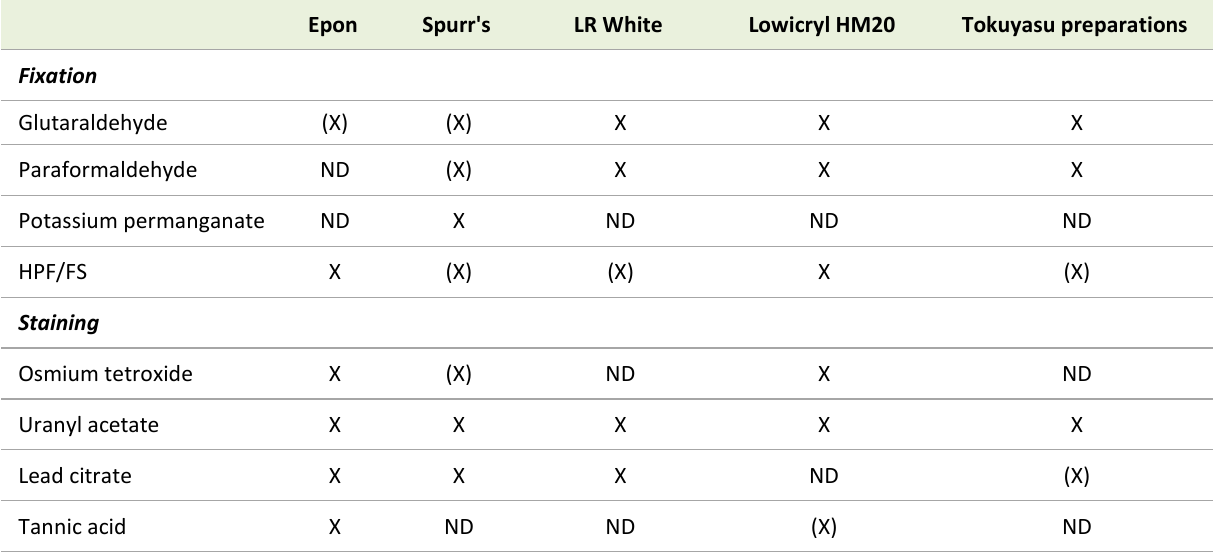
TABLE 2. Combinations of embedding media, fixation methods and staining procedures employed for yeast ultrastructural analyses. Epon